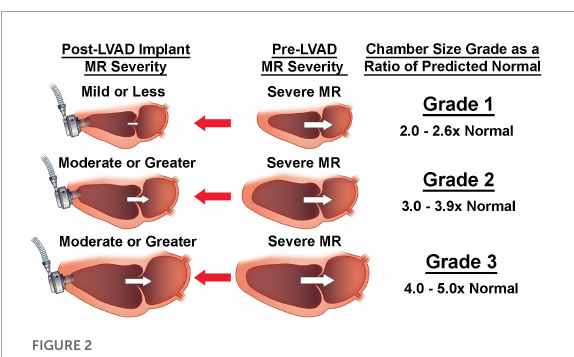
FIGURE2 Despite decompression by left ventricular assist device (LVAD) implantation, larger pre-LVAD left heart dimensions (grades 2 and 3) are less likely to down size sufficiently to allow mitral leaflet coaptation due to severe